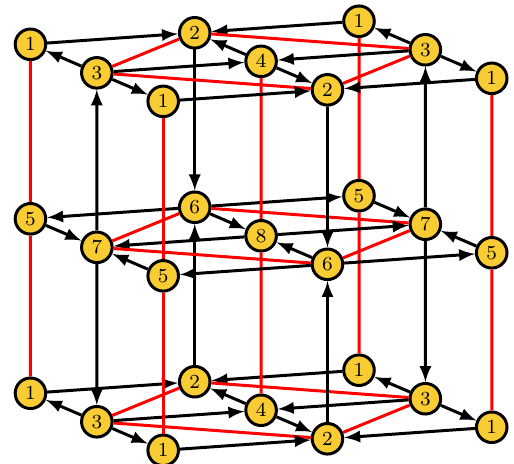
Figure 18. Periodic quiver for phase A of Q 1 ; 1 ; 1 = Z 2